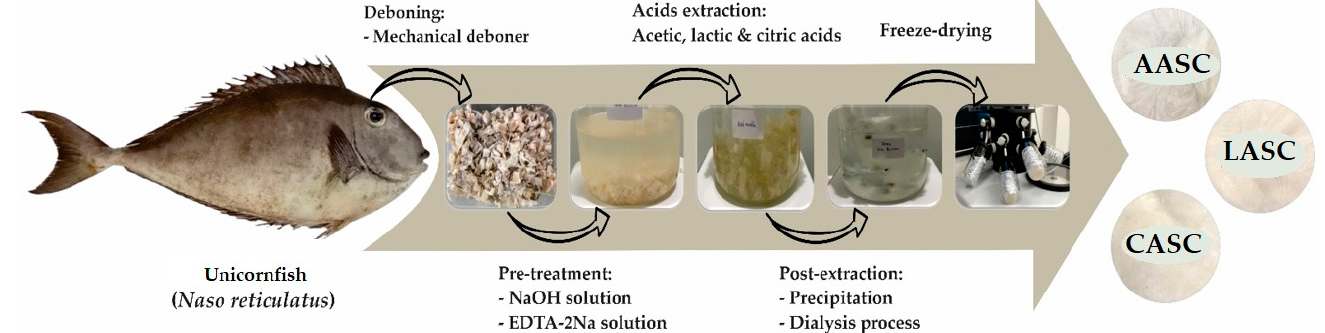
Figure 6. The procedure of acid-soluble unicornfish ( N. reticulatus ) bone collagen. AASC: acetic-acid-soluble collagen; LASC: lactic-acid-soluble collagen; CASC: citric-acid-soluble collagen.